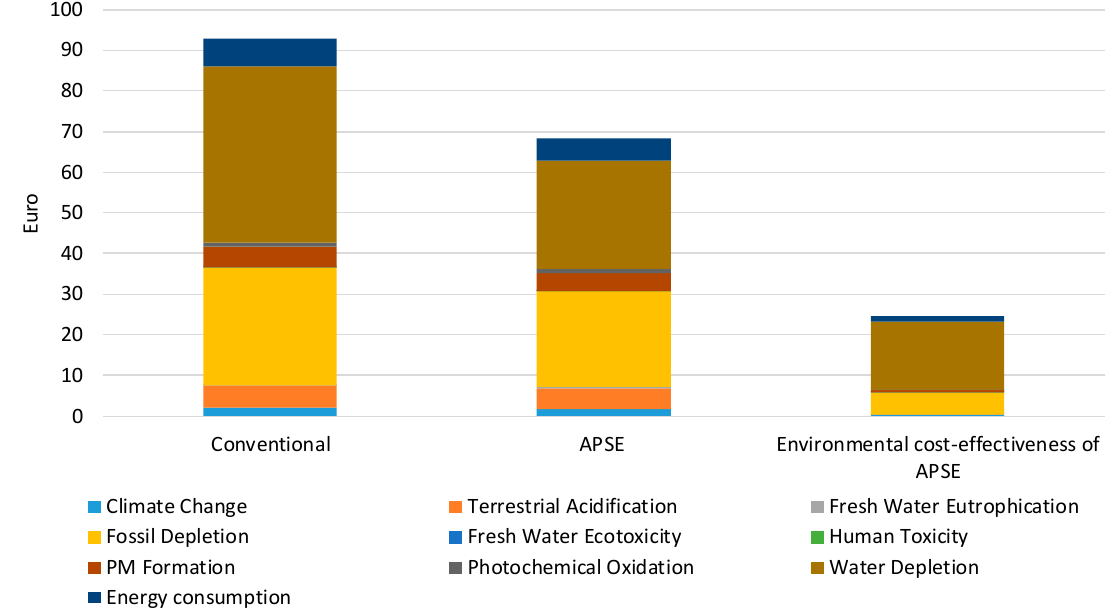
Figure 9. Environmental costs of 1 m 2 of pavement structure.